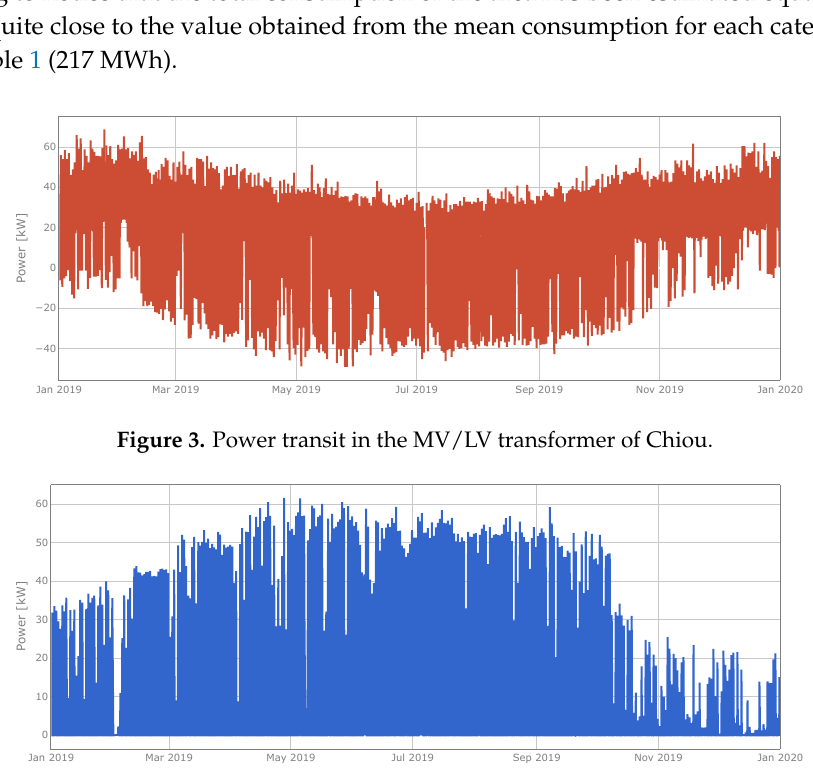
Figure 4. Power production of plants connected to LV grid of